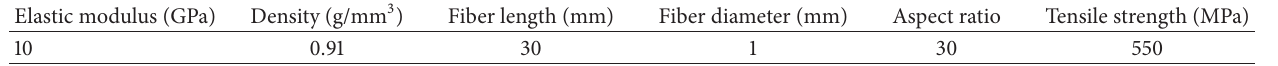
Table 5: Properties of macrosynthetic fiber.